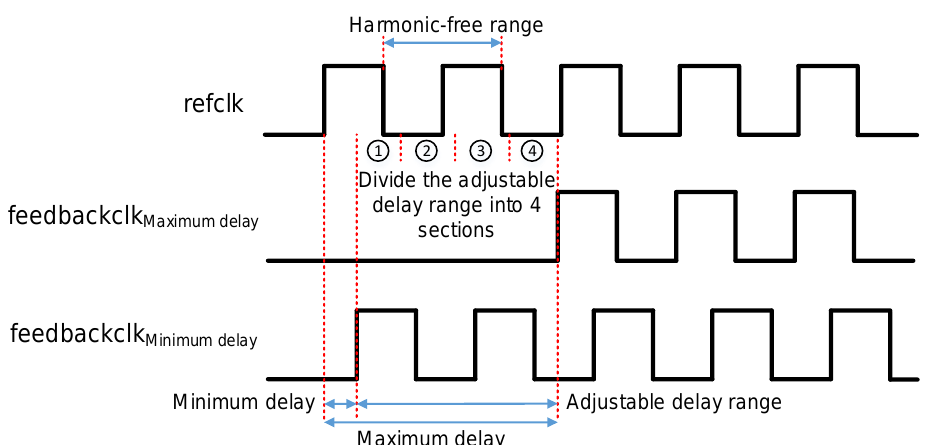
Figure 8. Diagram of the segmented method.